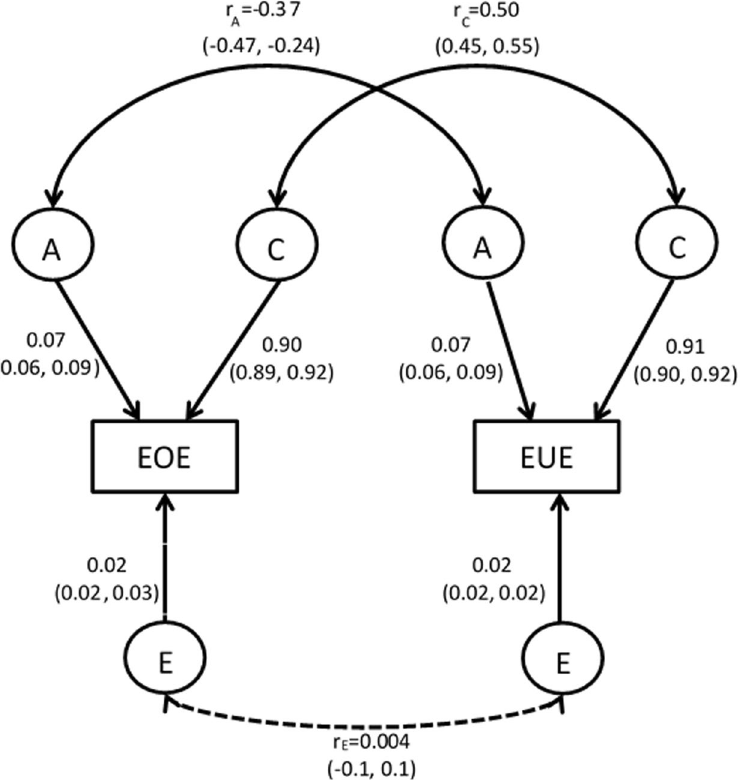
Figure 1. Full bivariate Correlated Factors Model, including all parameters. The rectangular boxes represent the measured phenotype (emotional overeating, EOE and emotional under-eating, EUE) using the Child Eating Behaviour Questionnaire at five years of age. The circles indicate the latent factors: additive genetic effects (A), shared environmental effects (C) and non-shared environmental effects (E). The straight single-headed arrows reflect pathways with the variance explained by each latent factor (including 95% confidence intervals, CI). The etiological correlations are shown on the curved double-headed arrows. These indicate the extent of common genetic (r A ), shared environmental (r C ) and non-shared environmental (r E ) influences across the two phenotypes. The non-significant etiological correlation (r E ), with a 95% CI crossing 0, is represented as a dotted line. Bivariate estimates (not shown on the path diagram) quantify the proportion of the phenotypic association (r = 0.41, p < 0.001) attributable to genetic (bivariate A = − 0.03, 95% CI: − 0.004, − 0.02), shared environmental (bivariate C = 0.44, 95% CI: 0.39, 0.48) and unique environmental factors (BivE: 0.00, 95% CI: − 0.00, 0.00) that are common to both EOE and